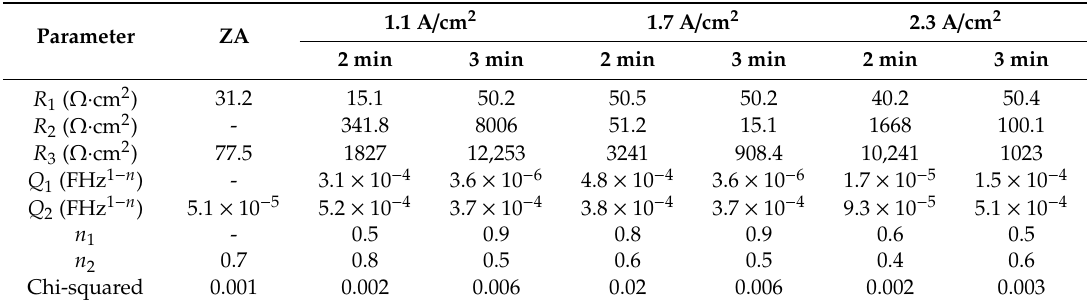
Table 3. Results of the fitting of experimental data. Standard deviation range of the single data are between 1% and